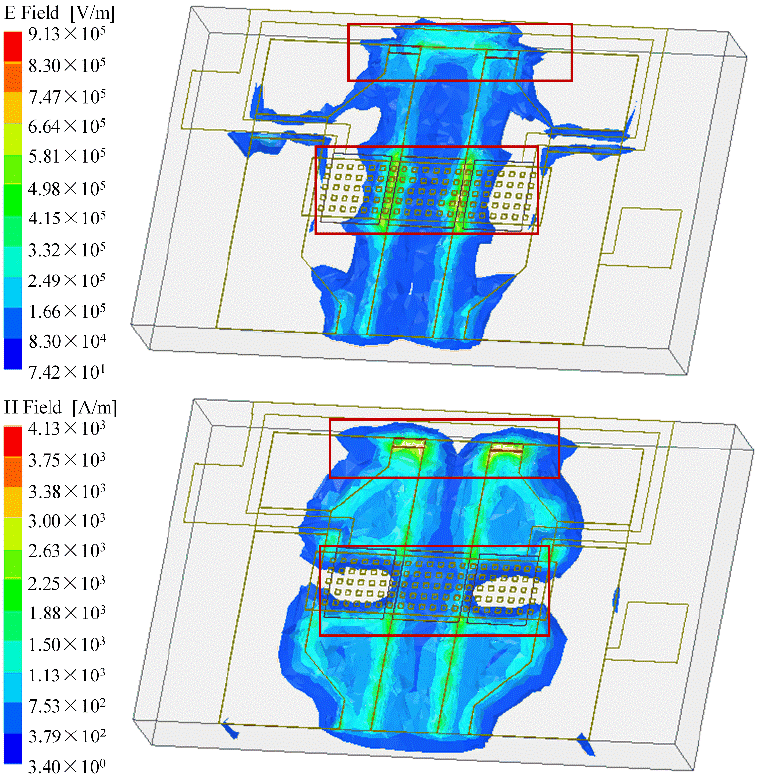
Figure 3. Electric and magnetic field distribution of cascaded MEMS demodulator simulated by Ansys HFSS.